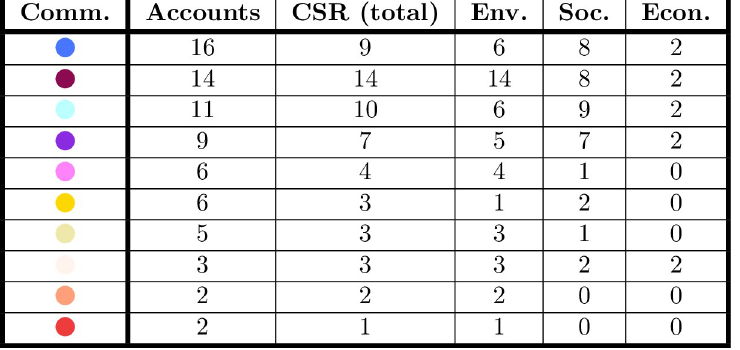
Fig 9. Frequency of accounts using the various CSR hashtags. The frequency of accounts using CSR hashtags is higher in the greater communities, with a 100% covering in the case of “Environmental Sustainability” (in purple).